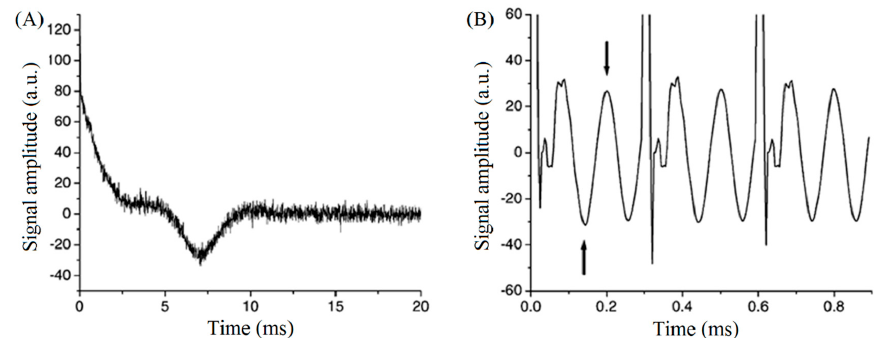
Figure 4. ( A ) Free induction decay (FID) and spin echo (SE) signals for a corn seed obtained in 15 s with a spin-echo sequence with τ e = 3.5 ms, 16 scans. ( B ) CWFP signal for the same sample and the same acquisition time of 15 s (16,666 acquisition windows of 3T p ), using 90 ◦ pulses, T p = 0.3 ms, and Φ = 5 π . Adapted from Publication [13], Copyright (2003), with permission from